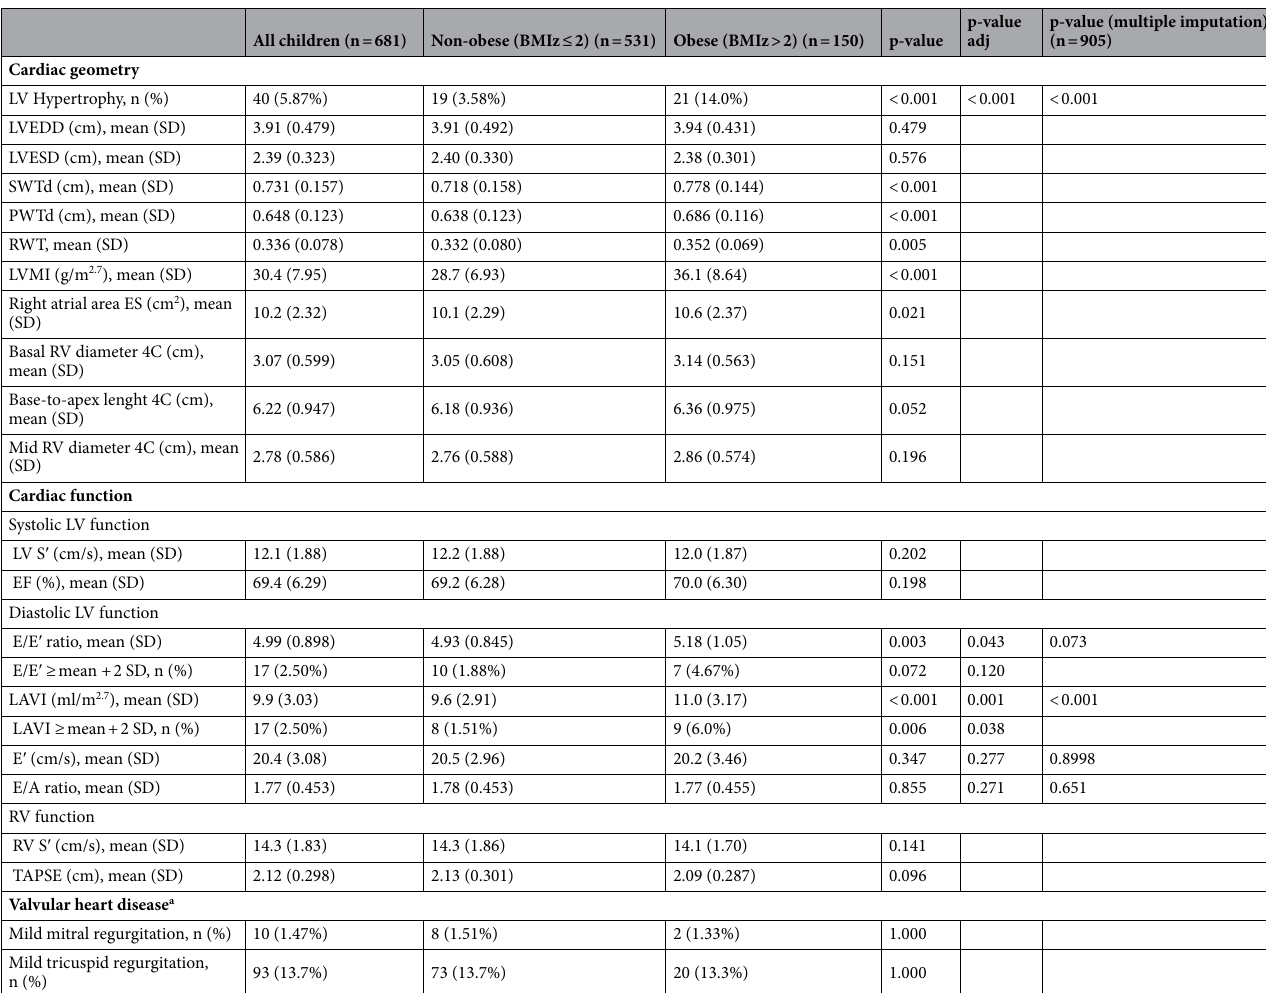
Table 2. Echocardiographic findings. Adj. p value p value adjusted for age and sex, 4C four-chamber view, BMIz BMI z-score, E inflow early diastolic flow velocity, E ′ mitral lateral peak early diastolic tissue